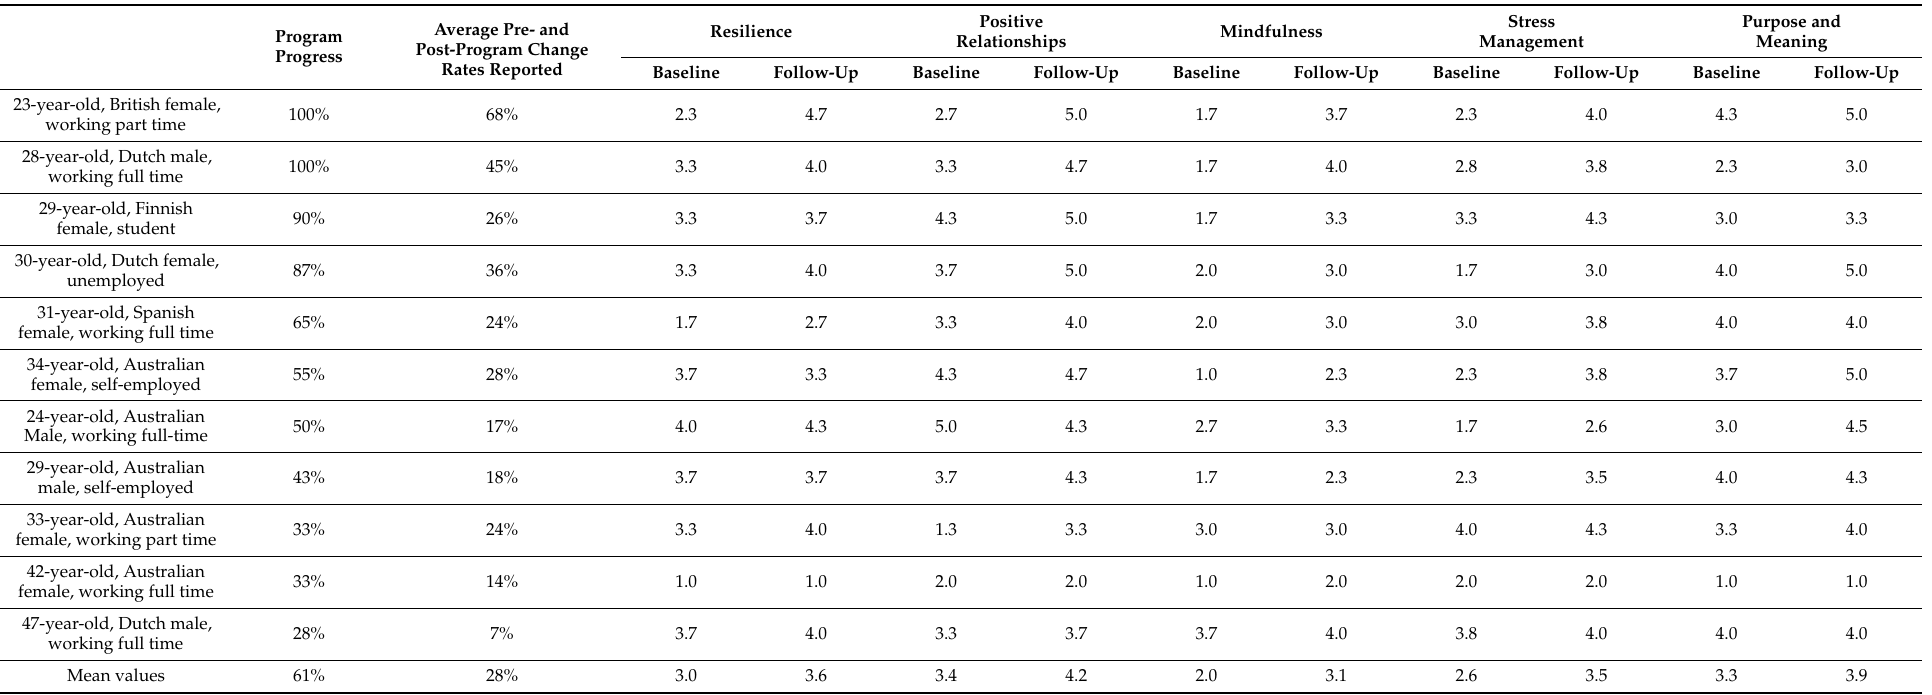
Table 1. Evaluation of well-being areas (per